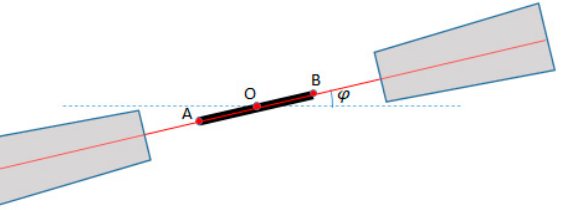
Figure 12. A tracklet in state 1: a single streak is detected, and the following streak can be on either side. State 2 —at least two streaks are associated with the tracklet, and therefore the speed